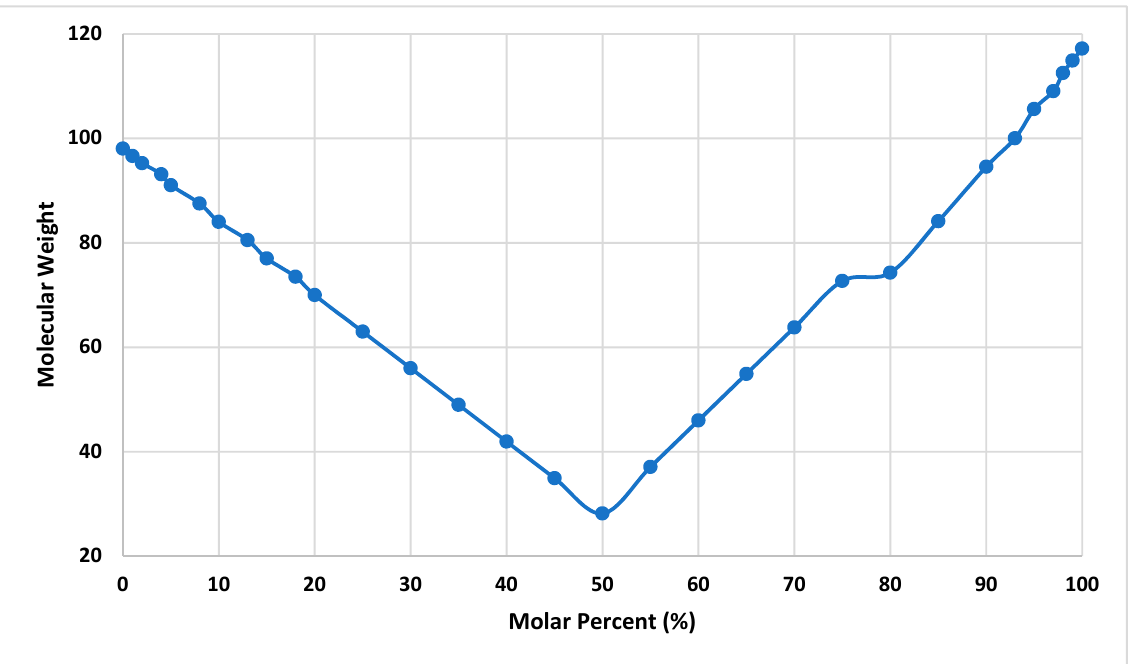
Figure 3. Molecular weight of precipitated pure LDPE plot.